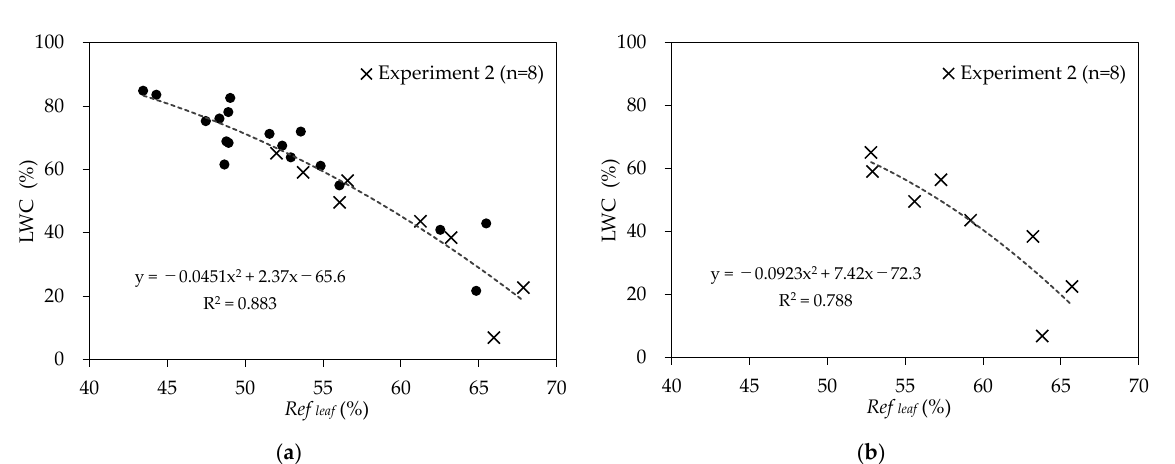
Figure 6. Correlation between the reflectance ( Ref leaf ) and leaf water content (LWC) of the individual sweet potato leaves. ( a ) Result of the LiDAR observation; ( b ) result of the hyperspectral camera observation (905 nm). The dashed line denotes the regression line.